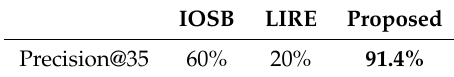
Table 6. Performances of the three systems on TestSet1000. IOSB LIRE